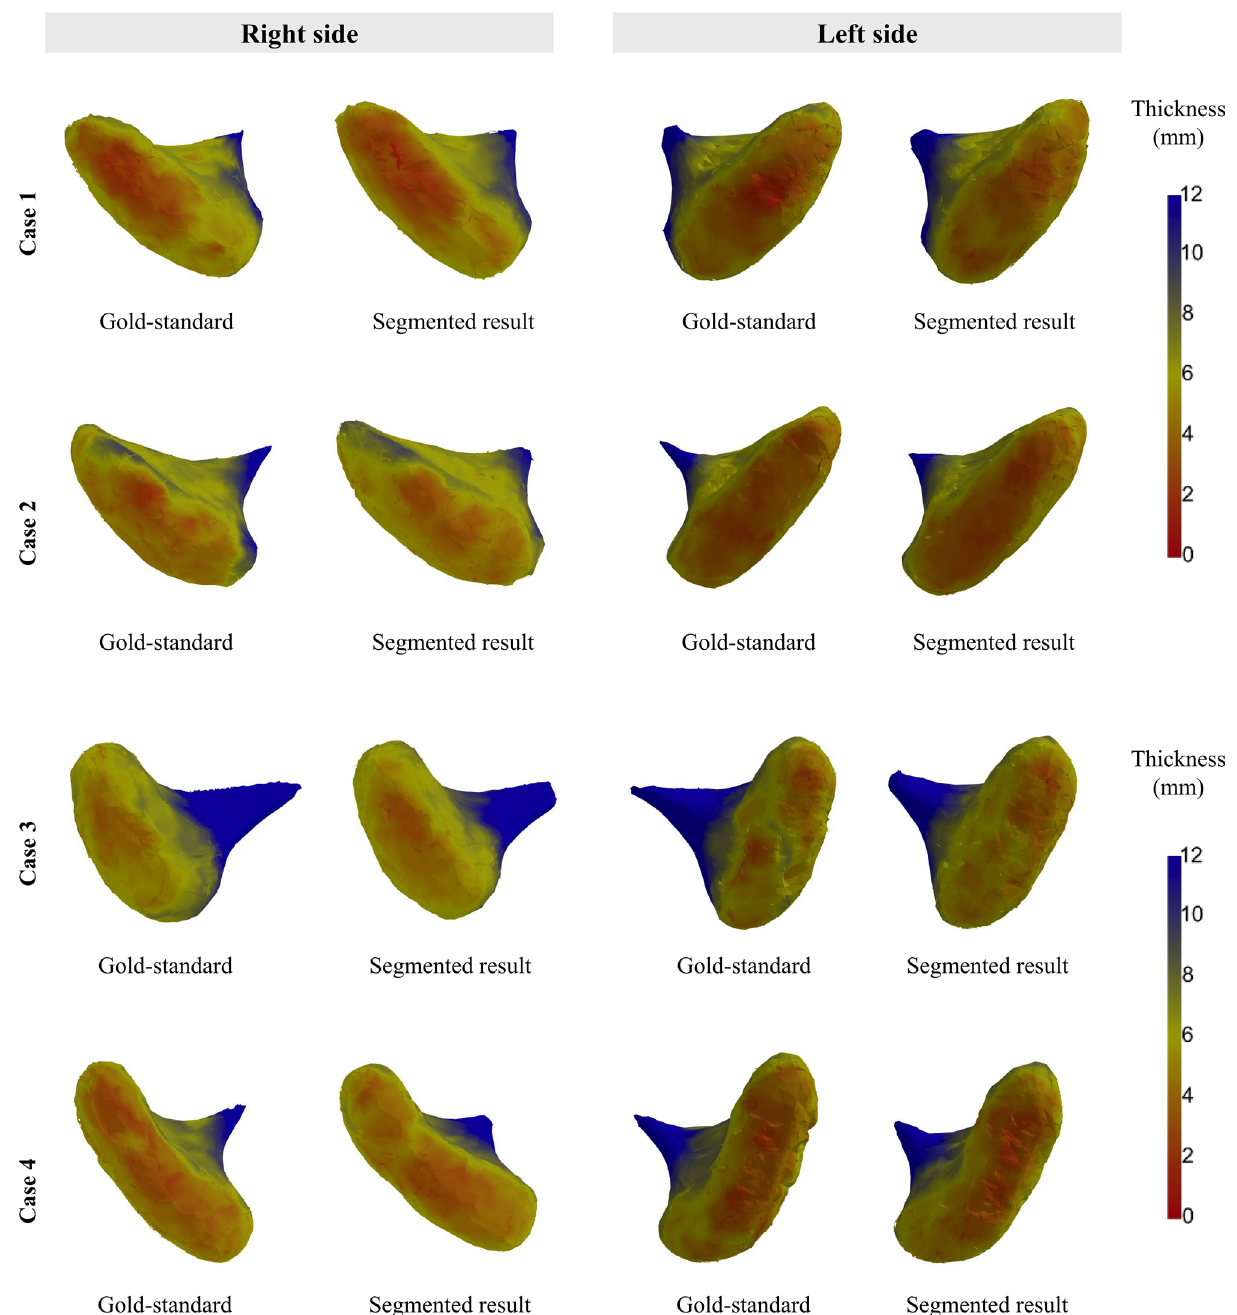
Figure 8. Visual comparison between the gold-standard and segmentation results by color mapping or cortical thickness on a three-dimensional temporomandibular condyle head